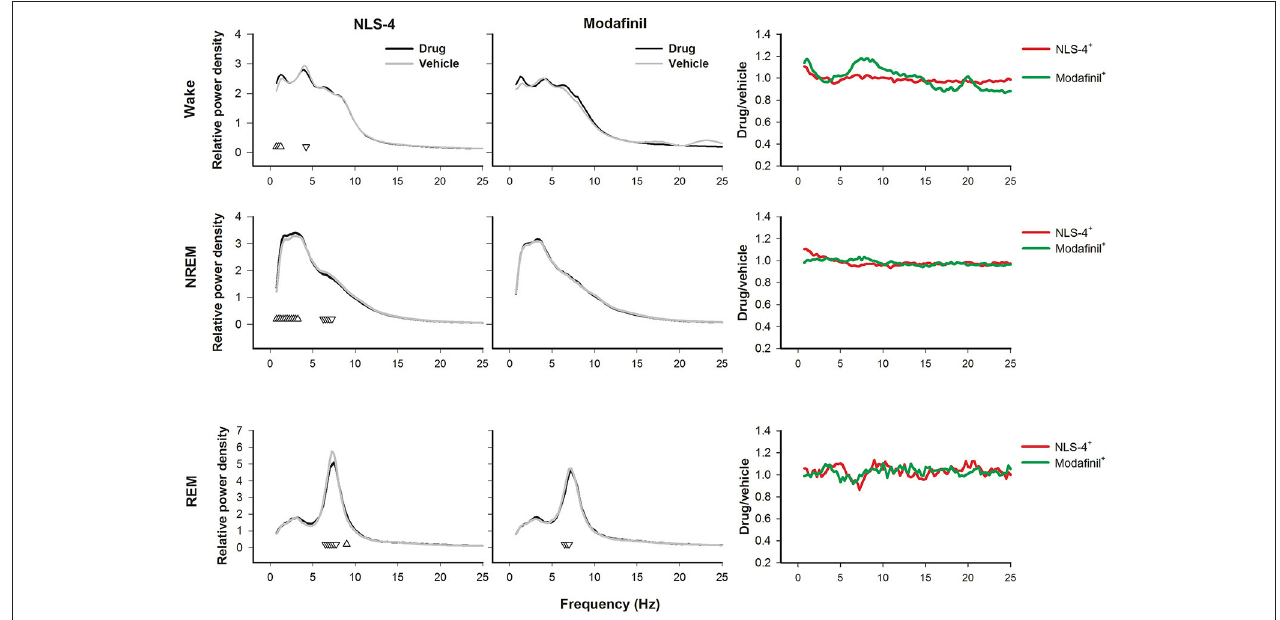
FIGURE 3 | Relative spectral profiles of wake, NREM and REM sleep after drug-induced wakefulness (from sleep onset till the end of the 24h recording). No changes were observed between modafinil and vehicle while NLS-4 showed increased power densities in delta frequency range [2-way repeated measures ANOVA, “treatment” p > 0.65, F (1, 5) = 0.22, “bin” p < 0.0001, F (97, 485) = 133.60, interaction p < 0.0001, F (97, 485) = 6.66]. Additionally, theta power density was decreased during NREM and REM sleep under NLS-4 treatment [2-way repeated measures ANOVA, “treatment”, p > 0.16, F (1, 5) = 2.57, “bin” p < 0.0001, F (97, 485) = 736.60, interaction p < 0.0001, F (97, 485) = 4.28; multiple comparisons: p < 0.05 for: 6.5–7.75Hz, with drug < vehicle]. Low delta power was increased during wakefulness after NLS-4 treatment while no changes were observed after modafinil [2-way repeated measures ANOVA, NLS-4: “treatment” p > 0.28, F (1, 5) = 1.45, “bin” p < 0.0001, F (97, 485) = 64.03, interaction p < 0.01, F (97, 485) = 1.55, multiple comparisons: p < 0.05 for: 0.75–1.25Hz, with drug > vehicle and 4.25Hz, with drug < vehicle]. Upward and downward triangles indicate significant increase or decrease in power, respectively.